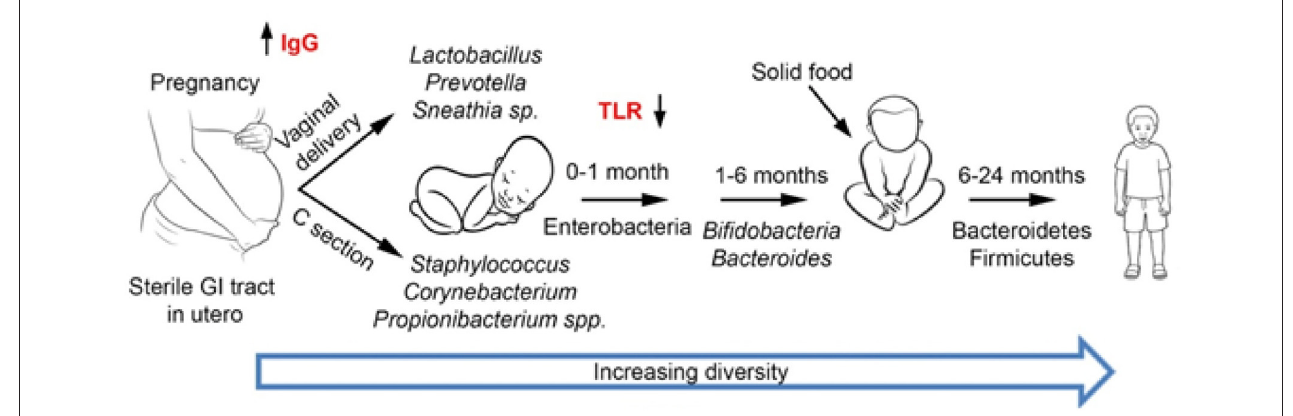
FIGURE 1 | Development of gut microbiota. During the first years of life, the microbiota is largely influenced by external factors, such as delivery mode and type of feeding (breast or artificial formula feeding). Subsequently, the intake of solid food as well as the gradual maturation of the immune system modulates the gut microbiota. By the age of 2–3 years old, the microbiota resembles that of an adult with Bacteroidetes and Firmicutes as the main